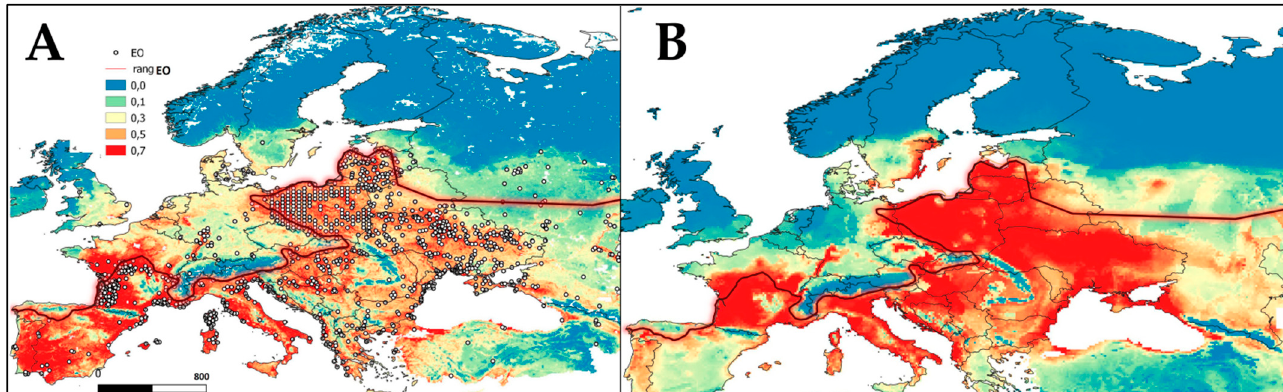
Figure 2. Potential (probabilistic) model of E. orbicularis expansion built in the Maxent program based on dataset: ( A ) GAEZ, current; ( B ) CliMond, 2090 dataset), GBIF data (2021). Areas with the highest habitat suitability (>0.5) are colored in red, and areas with the lowest (<0.1) in blue. The red line displays the current northern distribution border of native populations according to Fritz and Laufer (2007) [11,32].